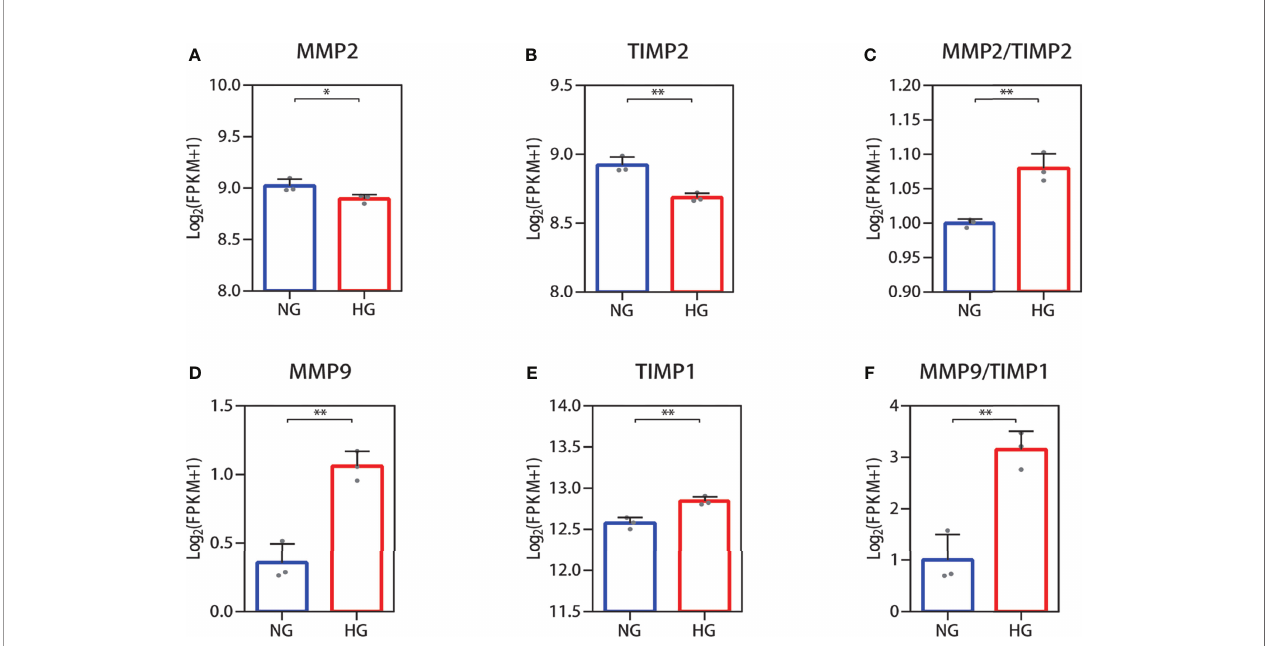
FIGURE 2 | RNA-seq quanti fi cation of the MMP-2/TIMP-2 and MMP-9/TIMP-1 ratio in high glucose-treated HDFs. (A – C) Quantitative expression pro fi ling of MMP-2 and TIMP-2 mRNA in HDFs and the MMP-2/TIMP-2 ratio. (D – F) The expression of MMP-9 and TIMP-1 mRNA in HDFs and the MMP-9/TIMP-1 ratio. The results are provided as the means ± SEM, * p < 0.05, ** p < 0.01 compared with the control.